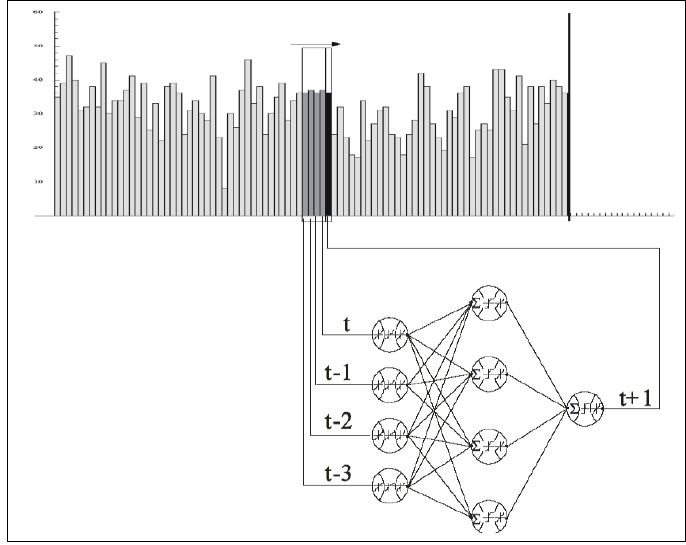
Figure 8. Example of neural network applications to time series predictions (e.g., using a (4-4-1)-multi-layer with four input neurons for observations x ( t ), x ( t – 1), x ( t − 2), x ( t − 3), four hidden neurons, one output neuron for x ( t + 1), and three layers of 20 trainable weights) [38].